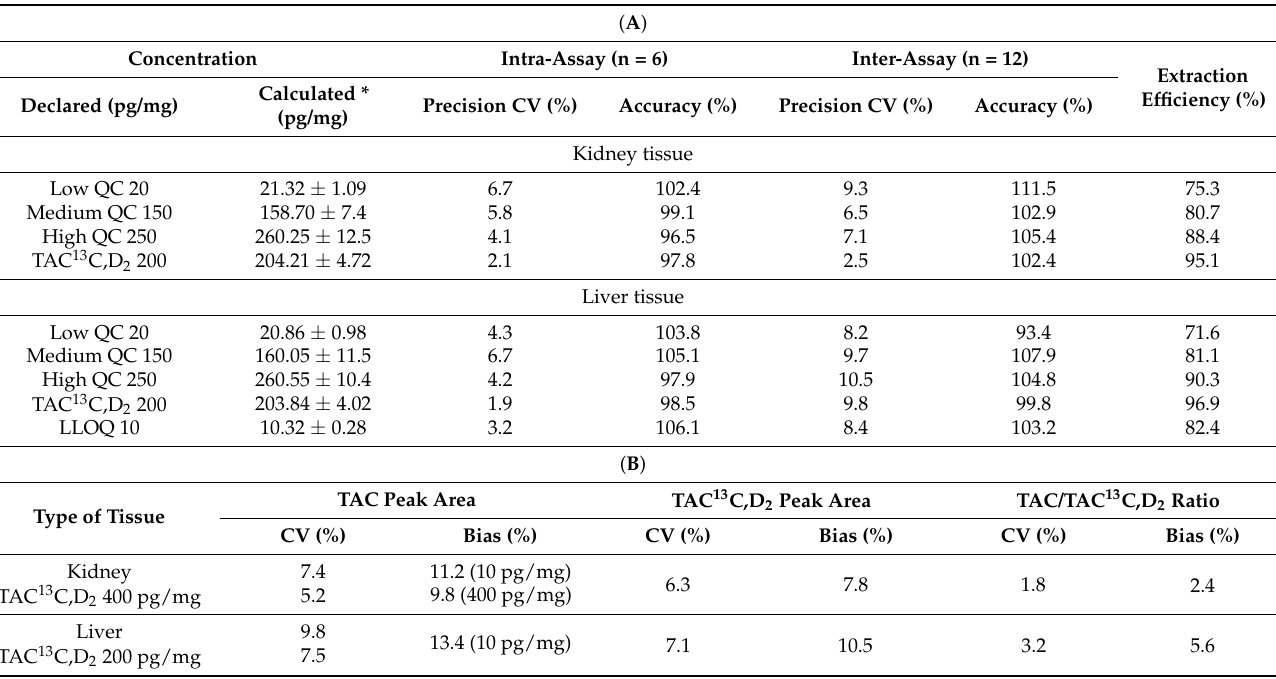
Table 1. ( A ) Intra-assay and inter-assay precision and accuracy of LC-MS/MS method for determining TAC in kidney and liver tissues at different QC tissue concentrations. ( B ) Matrix effects in human kidney and liver samples using the postextraction analyte-addition